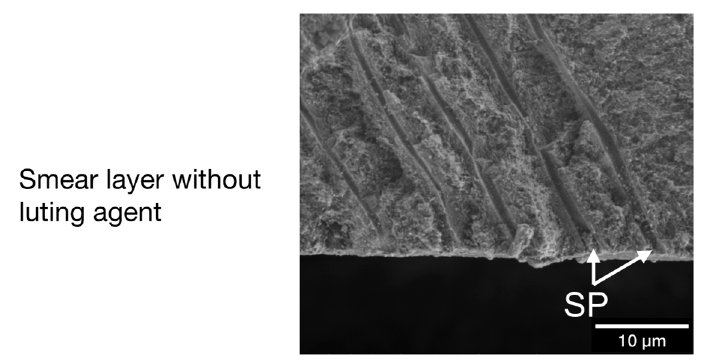
Figure 4. Exemplary micromorphology of a fractured specimen without material application revealing an undisturbed smear layer with smear plugs (original magnification